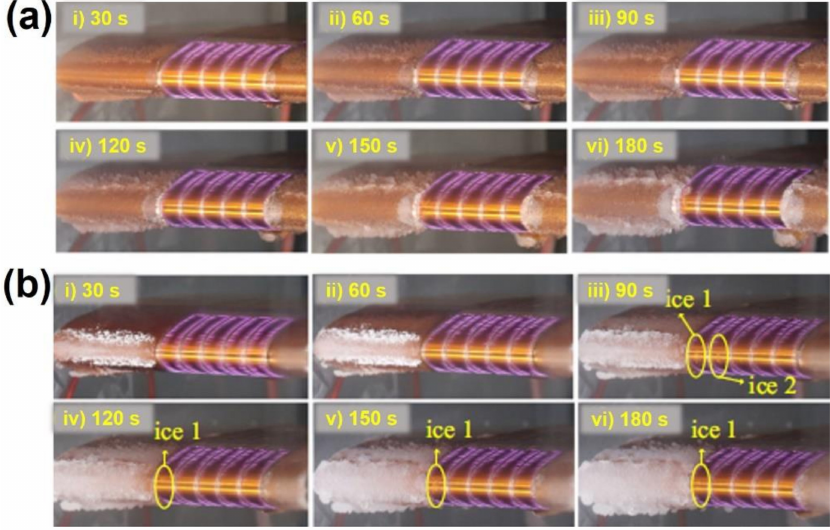
Figure 22. Time evolution of the dynamic anti-icing process at ( a ) T = − 5 ◦ C and ( b ) T = − 15 ◦ C (adapted from Wei et al. [119] with the permission of